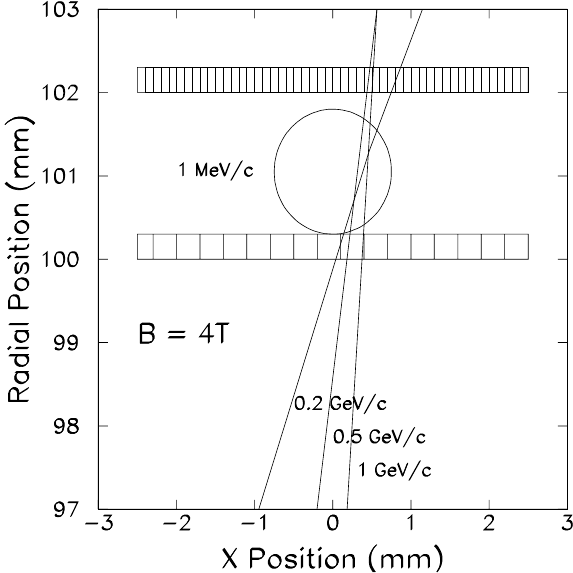
FIG. 73. Pixel microtelescope geometry 231, showing trajec- tories of 0.2 , 0.5 , and 1 GeV (cid:1) c tracks coming from the IP and bending in a 4 T